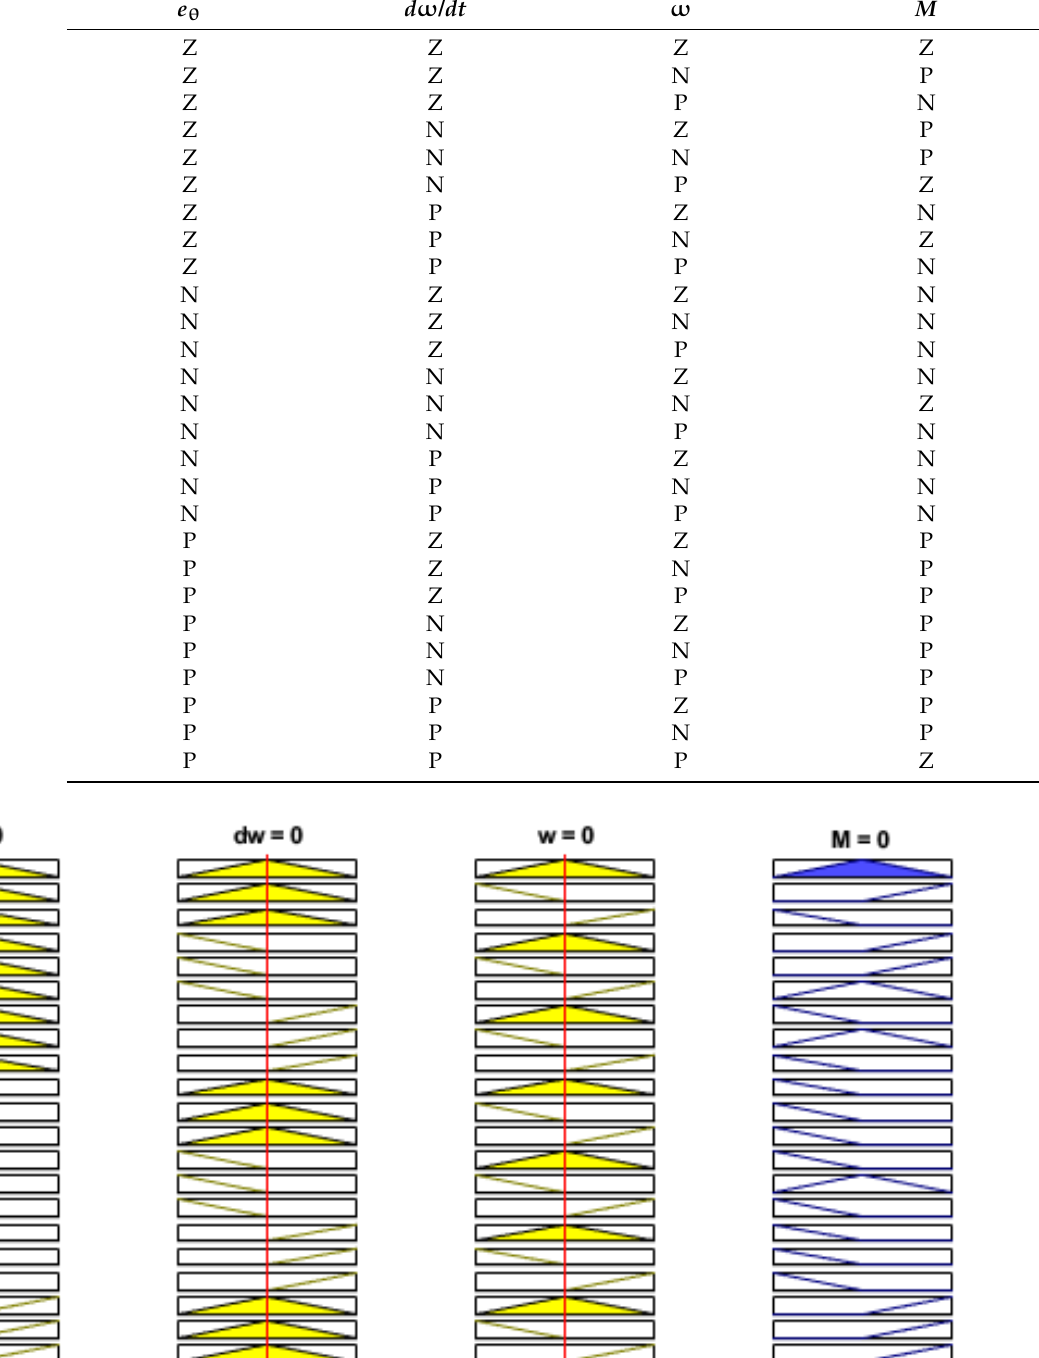
Table 1. Rule base.